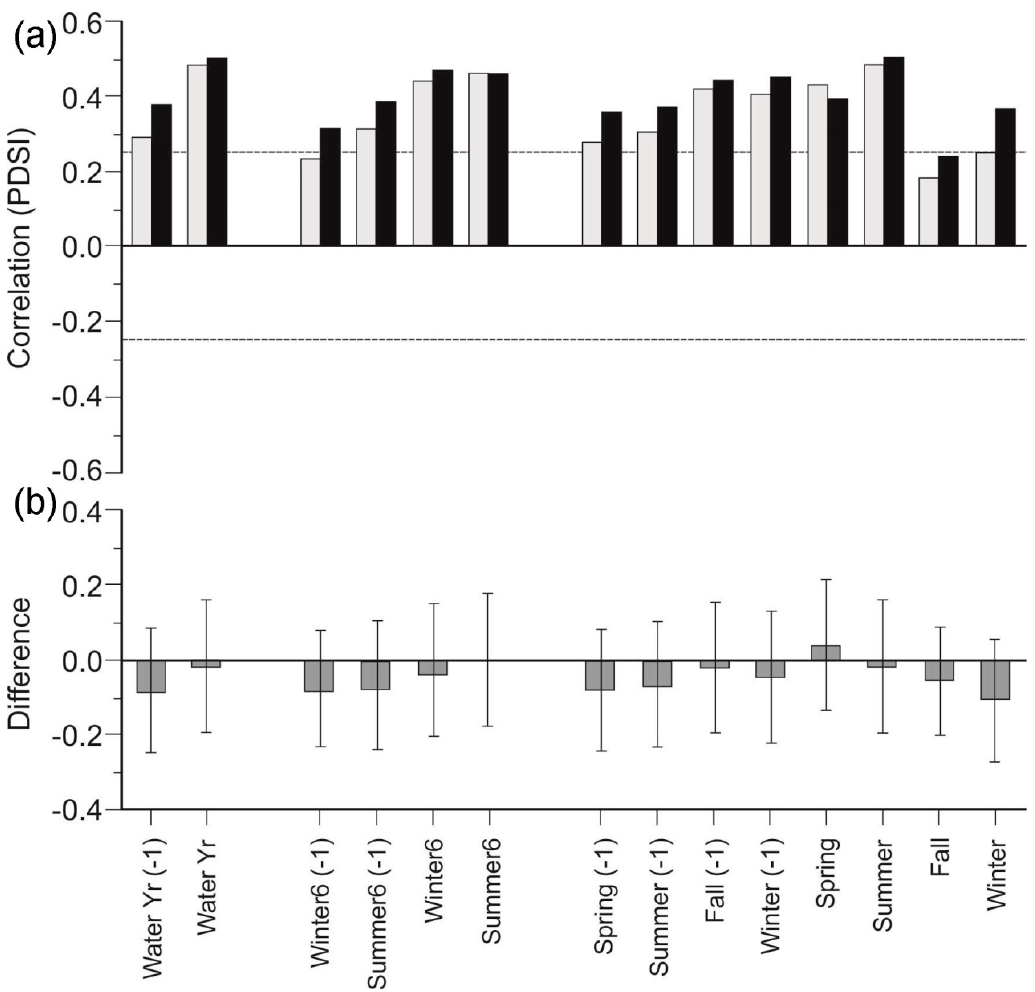
Figure 3. ( a ) Correlations between radial growth index of Douglas-fir growing at high density (light gray) and low density (solid) and seasonal values of the PDSI (see text for time windows). Significance levels and confidence limits are indicated as in Figure 2. ( b ) Growth–climate response differences for the two chronologies. Positive values indicate that Douglas-fir growing at high density are more positively correlated to the PDSI than Douglas-fir growing at low density during that season. The error bars indicate the 95% confidence limit on the difference.